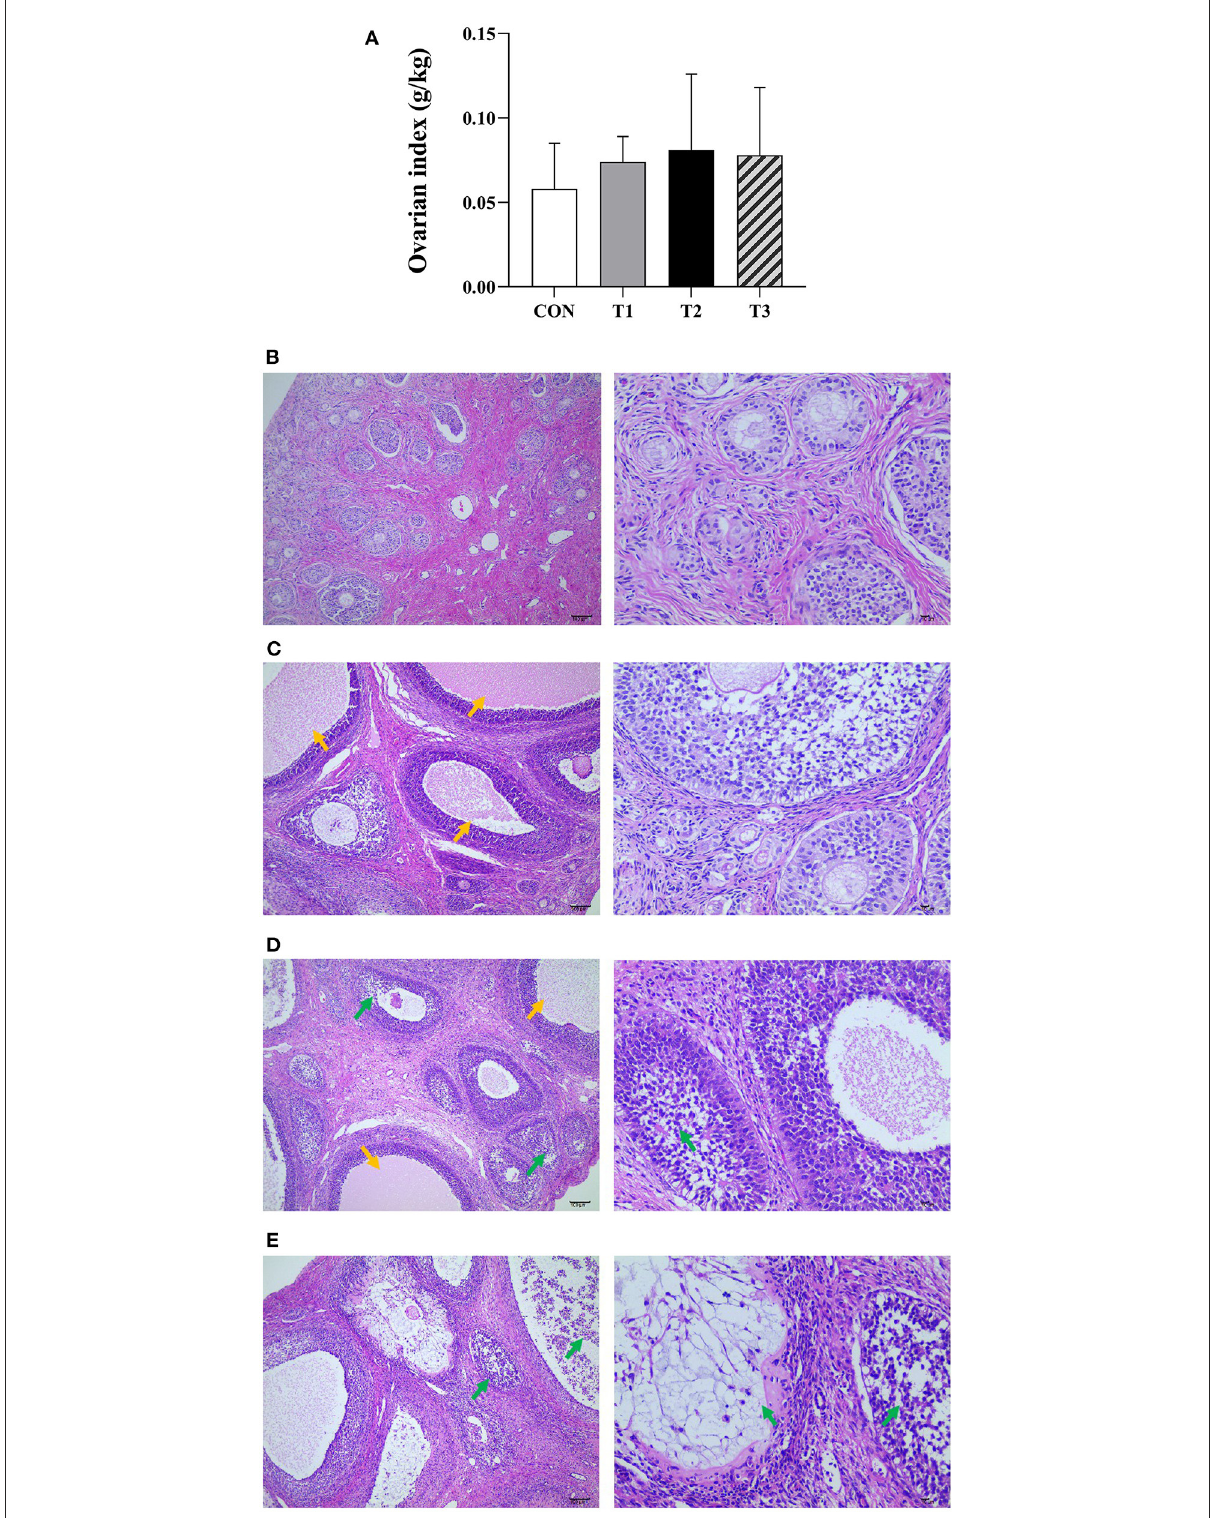
FIGURE1 Effects of ZEN on the ovarian index (A) , ovarian structure and morphology of prepubertal gilts (B–E) . (B–E) Images were taken at X100 (left) and X400 (right) magnification. Key: green- atretic follicle, yellow-secondary follicle simultaneous development. The magnification used was X100 and X400 and scales of 100 µ m and 10 µ m, respectively. In (A) , the letters above the bar are the same, indicating non-significant difference